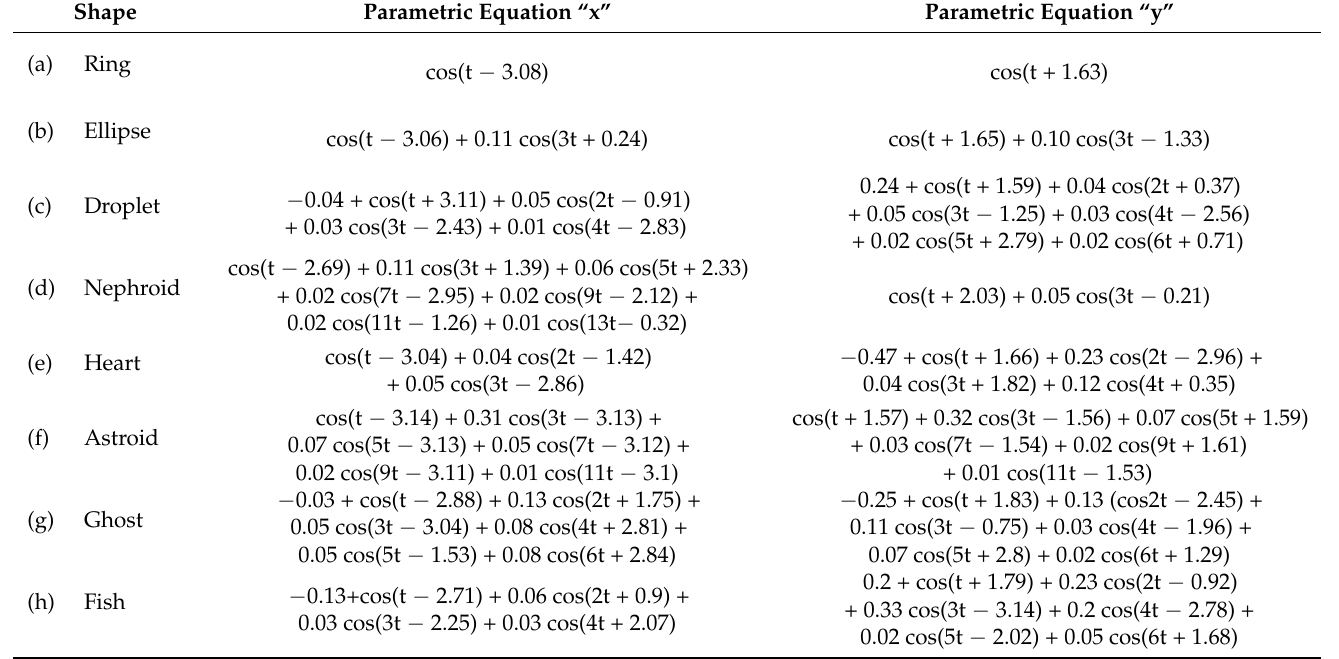
Table 1. Estimated parametric equations for shapes presented in Figure